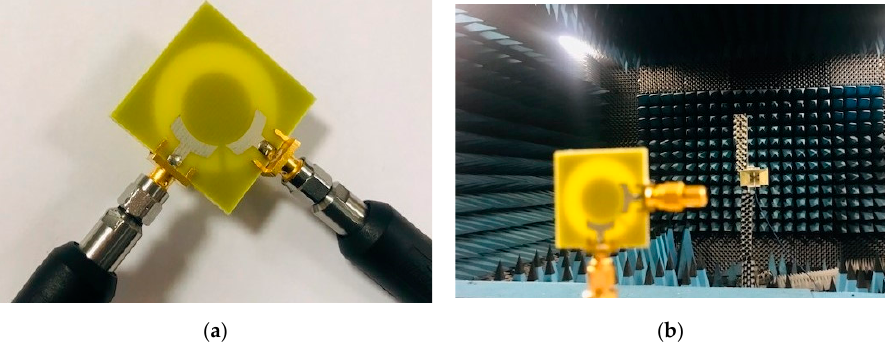
Figure 11. Photographs of the antenna in measurements setup of ( a ) S ‐ parameters and ( b ) radiation patterns.